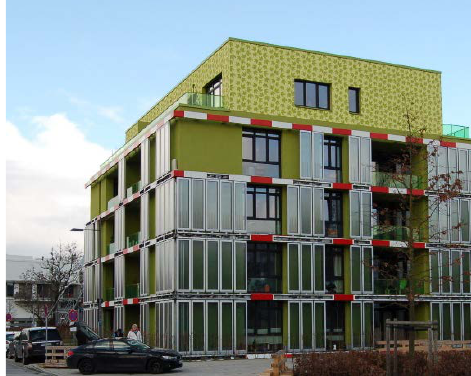
Figure 2: A bioactive facade installed at the BIQ- Algenhaus in Hamburg,